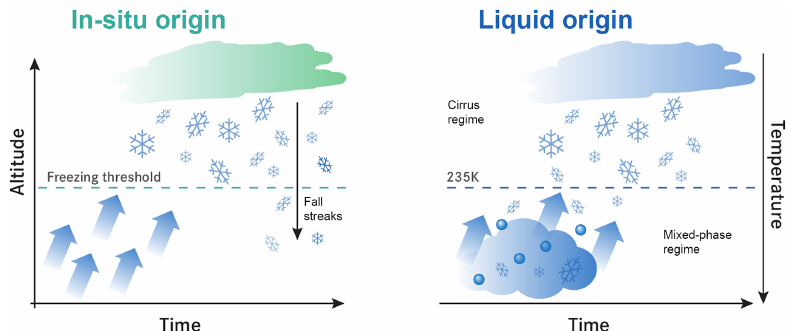
Figure 1. Schematic of the basic mechanism surrounding in situ origin cirrus (left) and liquid origin cirrus (right). Each scenario illustrates the movement of air and/or cloud particles from their origin to a cirrus cloud. Left panel (in situ origin): the “freezing threshold” indicates where heterogeneous and/or homogeneous ice nucleation takes place and cirrus development begins. Right panel (liquid origin): the cloud particles first form in the mixed-phase region of the atmosphere and become ice through heterogeneous or homogeneous drop freezing. After crossing the 235K threshold, liquid water no longer exists, which indicates the boundary of the cirrus region of the